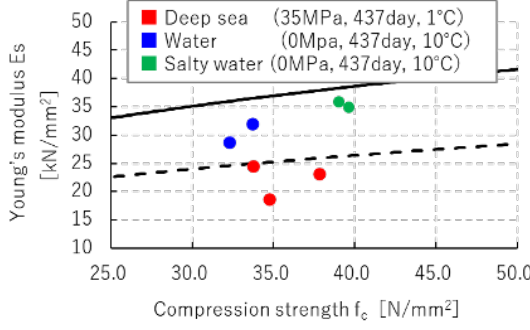
Figure 10. Poisson’s ratio ν . X-axis represents the exposure conditions and number of